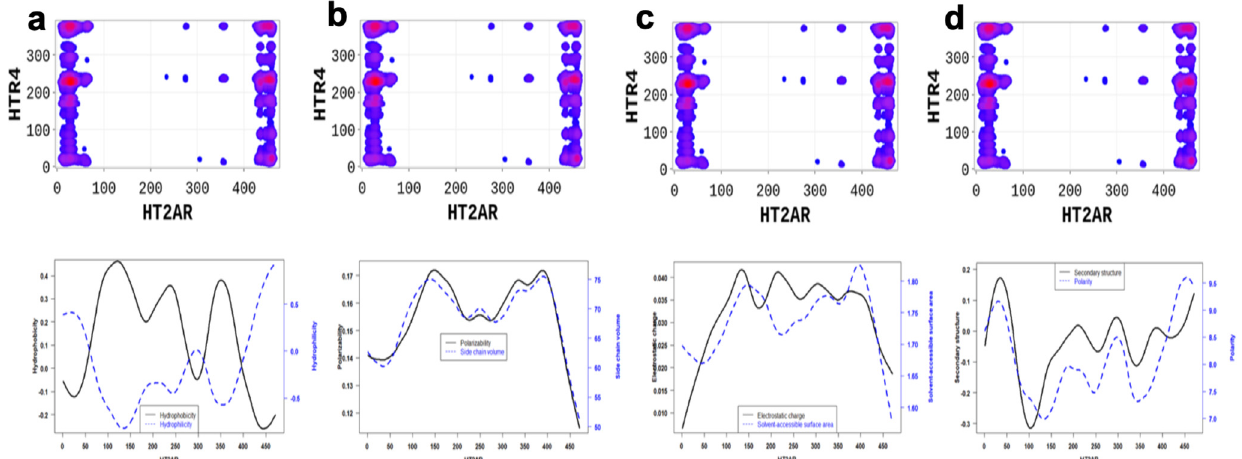
Figure 7. 5-HT2AR/5-HTR4R dimerization is highly driven by ( a ) the hydrophilicity, ( b ) the polarizability and side chain, ( c ) the electrostatic charge and polarity, and ( d ) the secondary structure similarity and solvent accessibility properties of the 5-HT2AR amino-acids located at the interfaces. These properties are significantly different at the predicted binding interfaces than non-binding peptides.